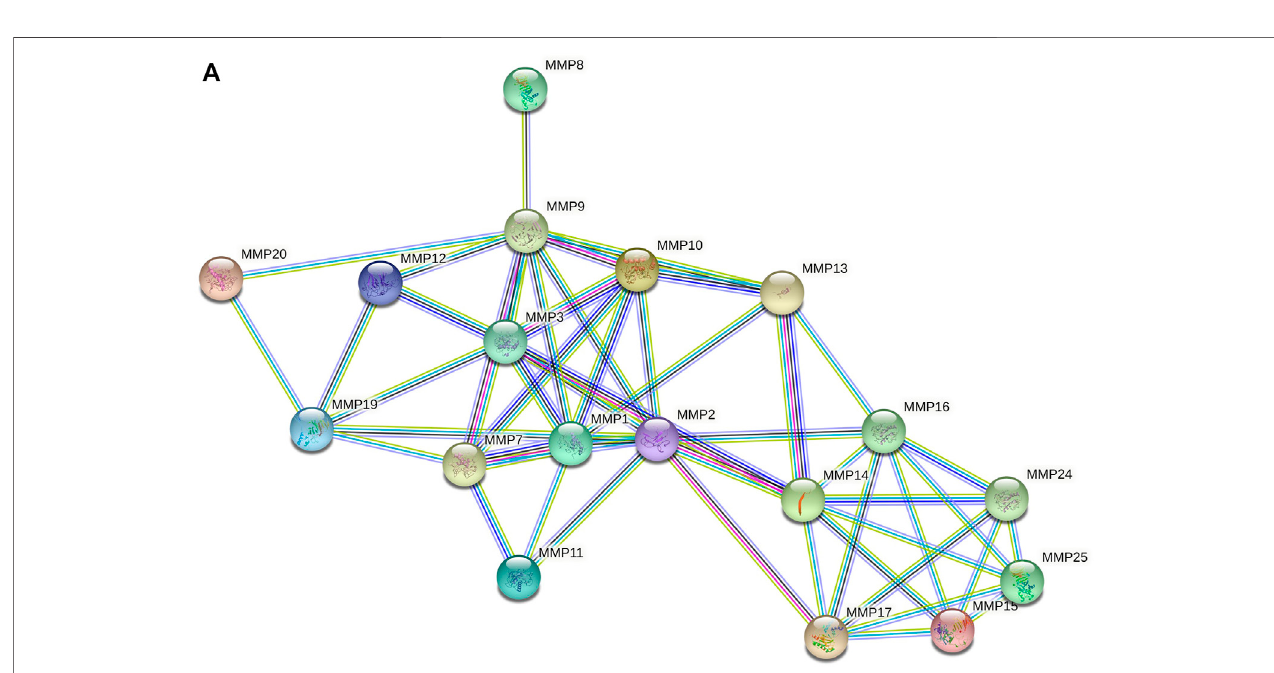
FIGURE 7 | Protein-protein mutual aid and interaction analysis diagram of MMPs. (A) Protein protein mutual aid analysis diagram of MMPs (String). (B) Protein protein interaction analysis diagram of MMPs and its related molecules (GeneMANIA).